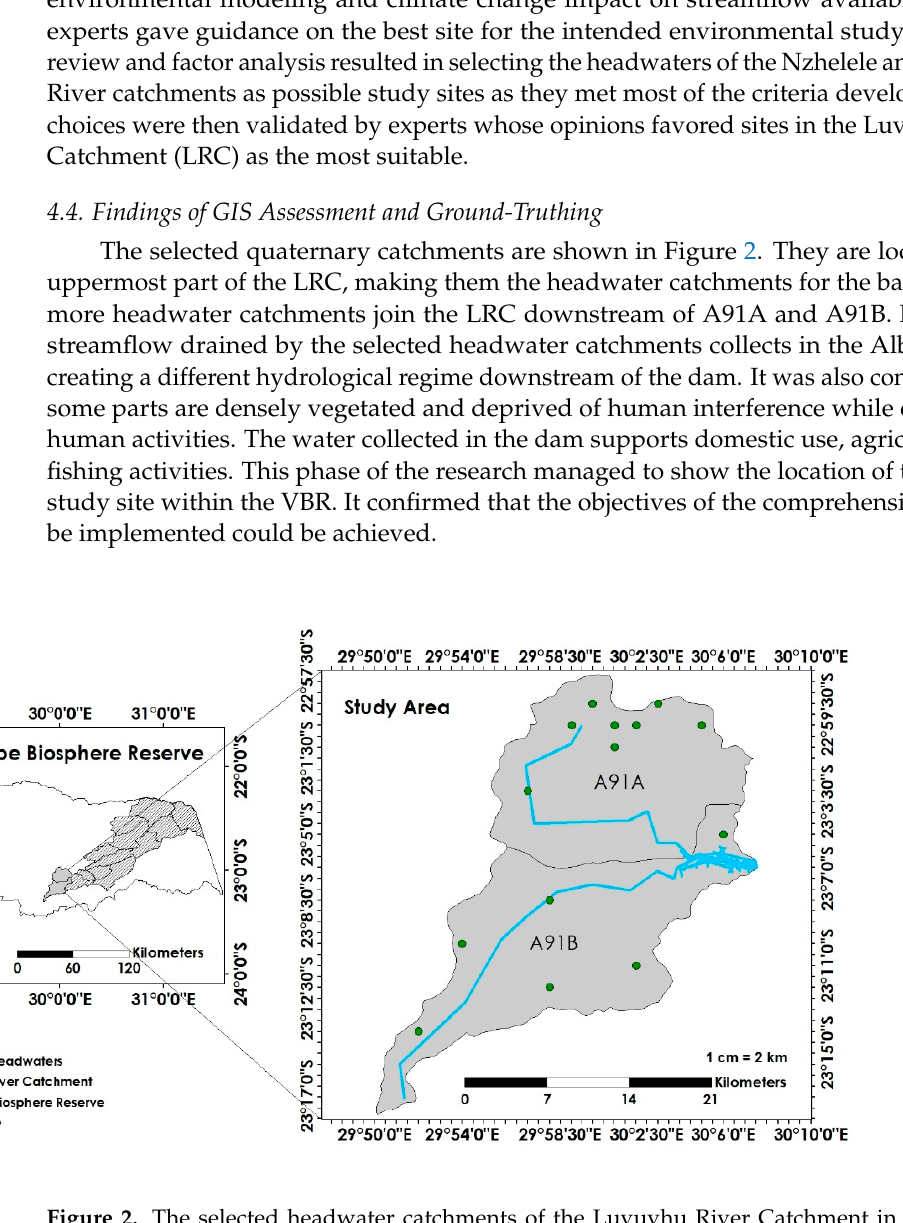
Figure 2. The selected headwater catchments of the Luvuvhu River Catchment in the Vhembe Biosphere Reserve.